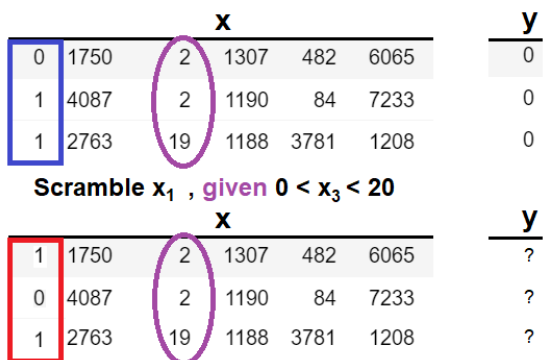
Figure 7. In the conditional mean decrease in accuracy (C-MDA) approach, the permutation is only performed on the values of a feature given the presence of another feature falling within a range of values. By contrast, permutation in traditional MDA (as shown in Figure 6) is performed on all values of a feature, with no consideration of other